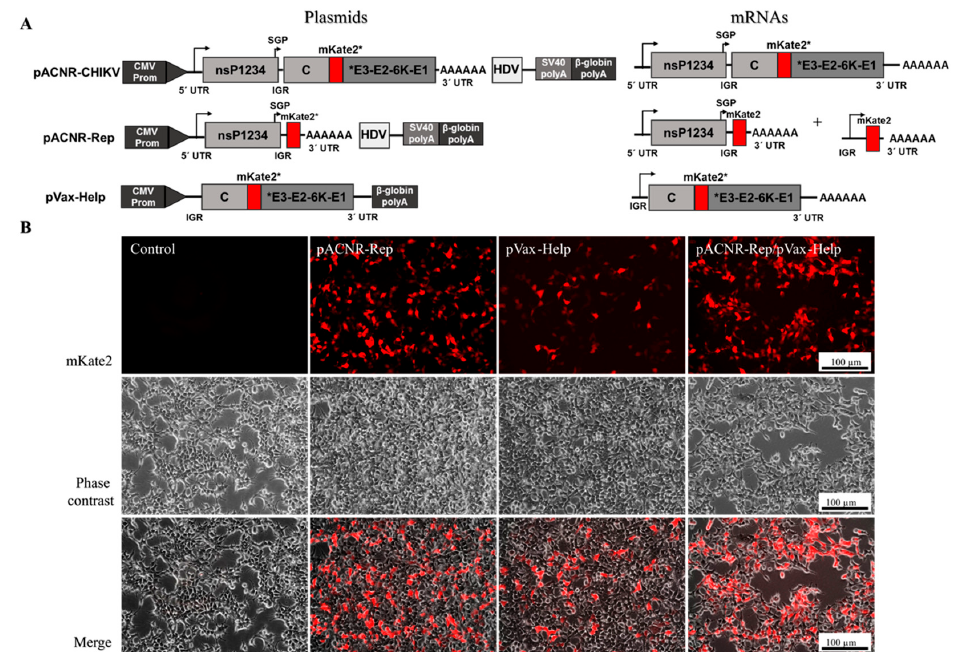
Figure 4. Generation and evaluation of replicon and helper vector system. ( A ) Constructions of pACNR-CHIKV, pACNR-Rep, and pVax-Help plasmids. The genomic CHIKV was inserted into the pACNR1811 vector from which the human cytomegalovirus (CMV) immediate early enhancer and promoter sequences, the SV40 polyA, and hepatitis delta virus (HDV) to generate pACNR-CHIKV. The structural proteins were removed to generate pACNR-Rep and derived from pVax-CHIKV and the nonstructural proteins were removed to generate pVax-Help. The asterisk means that mKate2 is a reporter gene. ( B ) HEK-293T cells transfected with pACNR-Rep, pACNR-Help, and co-transfected with both vectors after 48 h. Fluorescence micrographs with mKate2 expression (mKate2 channel), the morphology of cells in phase contrast, and a merge. Bar, 100 µ